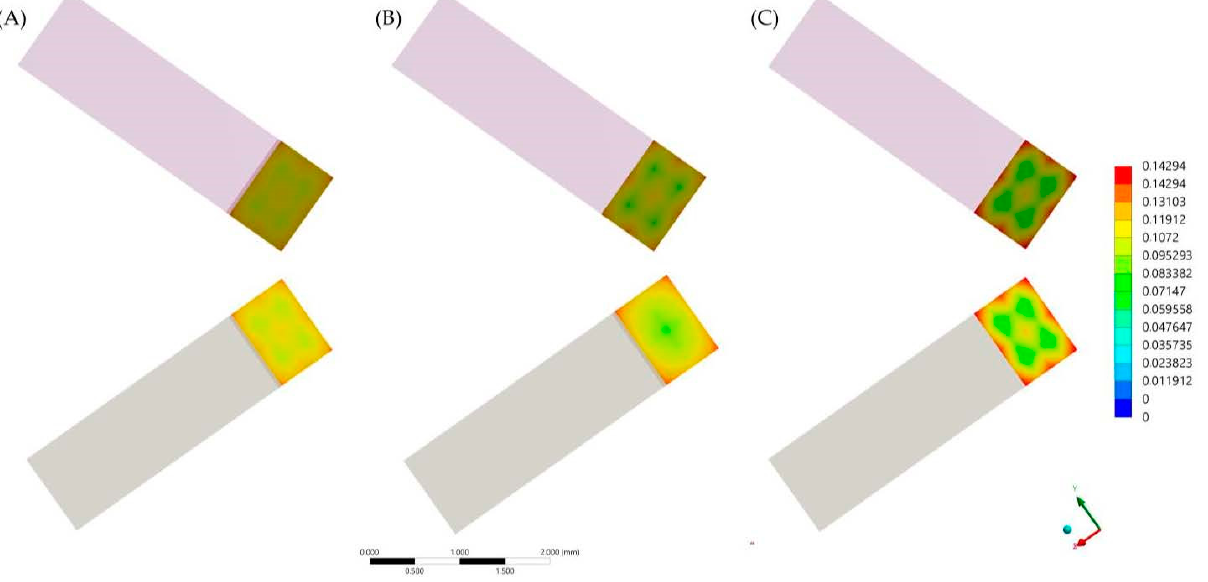
Figure 7. First principal stress (tensile) distribution in the ceramic (upper row) and dentin tissue (lower row) for each evaluated group. ( A ) Models with 60 μ m of cement layer thickness; ( B ) Models with 120 μ m of cement layer thickness and ( C ) Models with 180 μ m of cement layer thickness. Table 6. Stress peaks (in MPa) calculated * for each adhesive interface